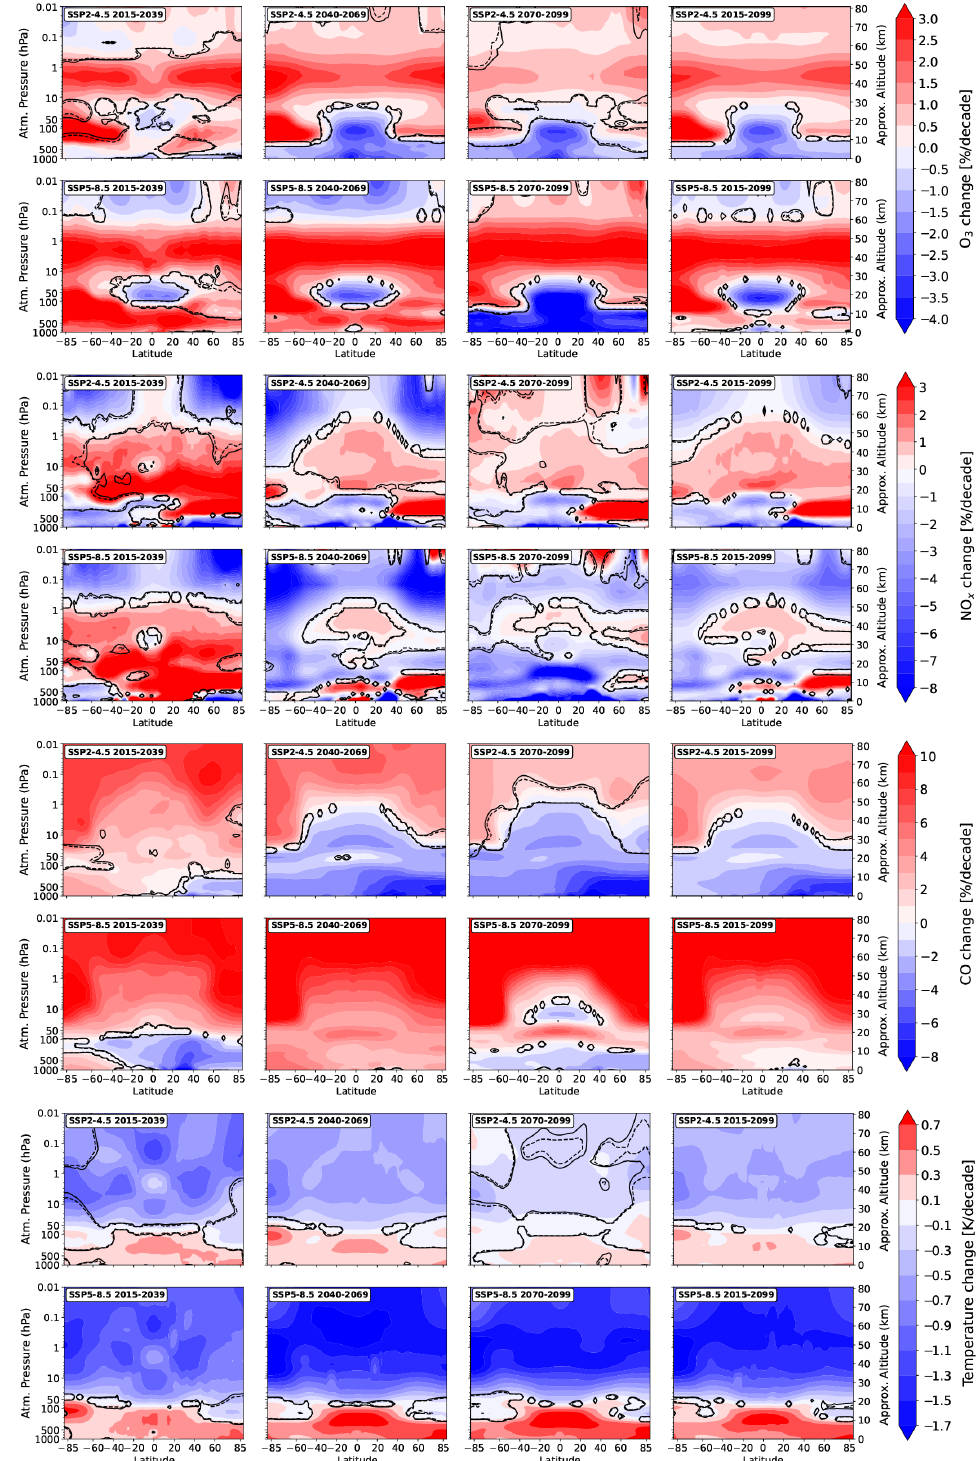
Figure 3. Profiles of trends in O 3 , NO x , CO, and temperature for the 2015–2099 period and different subperiods from both SSP2-4.5 and SSP5-8.5 simulations. The names of the corresponding scenario and the period are indicated in the upper left corner of each panel. The dashed line is the delimiter of the region, with significance at the 90% level for positive or negative changes; the solid line is the same at the 95%